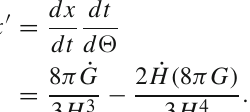
Fig. 11 The phase plot of unstable saddle point ( 0 , 0 ) for analysing stability at infinity for case I when γ = 4